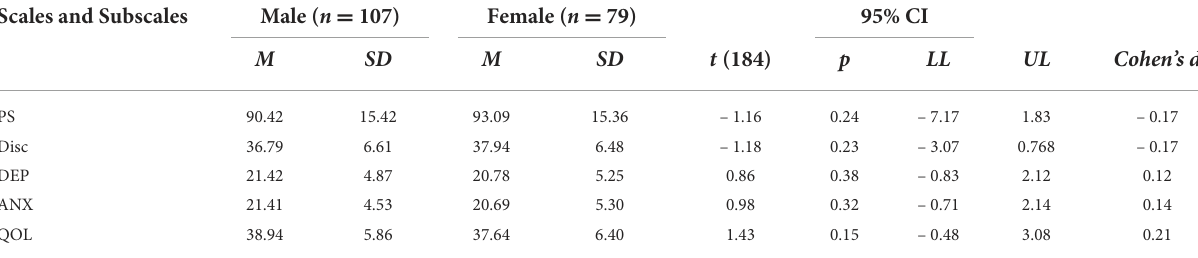
TABLE 3 Independent samples t -test showing mean, standard deviation and t -values for gender among study variables.